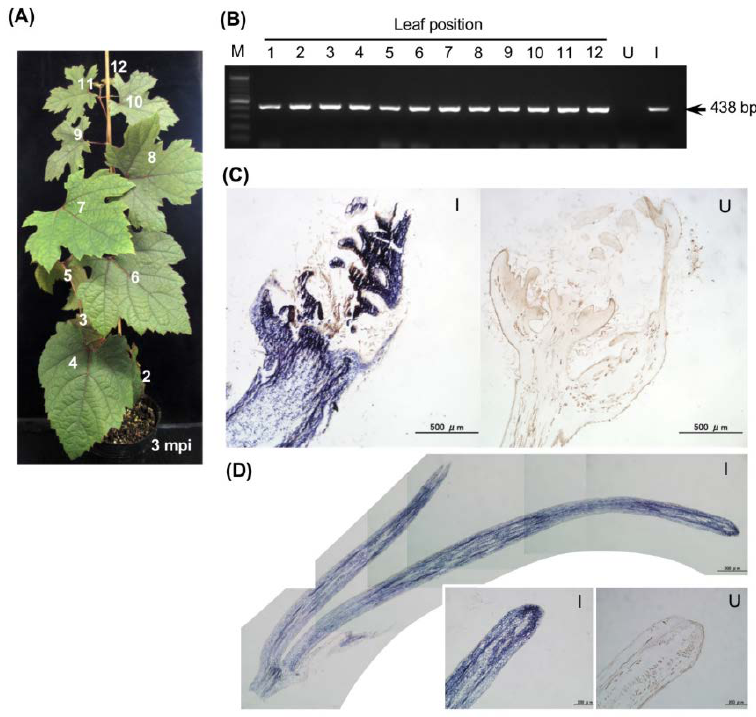
Figure 3. Systemic distribution of wtALSV in a grapevine seedling inoculated at the ‘folded cotyledons’ stage. ( A ) An infected grapevine seedling without visible symptoms three months post inoculation (mpi). Numbers indicate leaf positions used for detection of infection in ( B ). ( B ) Detection of wtALSV by RT-PCR from true leaves from the grapevine seedling shown in ( A ). M, DNA size maker; U, uninfected sample; I, infected sample. ( C ) In situ hybridization analysis of shoot tips from infected (I, left) and uninfected (U, right) grapevine seedlings using an ALSV-Vp24 ( − ) probe. ( D ) In situ hybridization analysis of tendrils of infected (I) and uninfected (U) grapevine seedlings probed with ALSV-Vp24 ( − ). Blue colour indicates ALSV distribution.